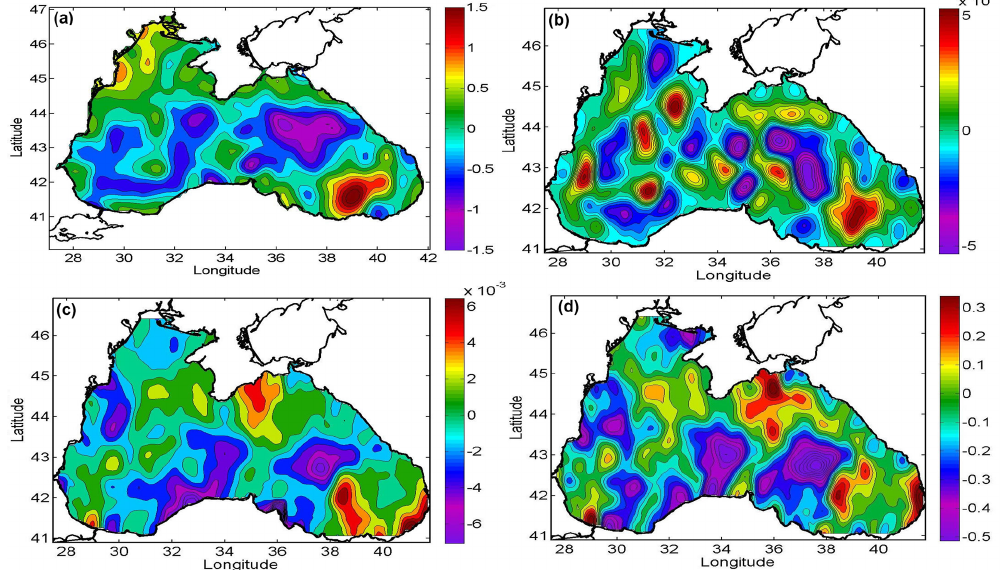
Figure 7. Spatial distribution of (a) DSL trends (mmyr − 1 ). (b) Trends in the frequency of anticyclones in 1993–2014 (1yr − 1 ). (c) Trends in the maximum orbital velocity of anticyclones in 1993–2014 (ms − 1 yr − 1 ). (d) Trends in the radius of anticyclones in 1993–2014 (kmyr − 1 ).